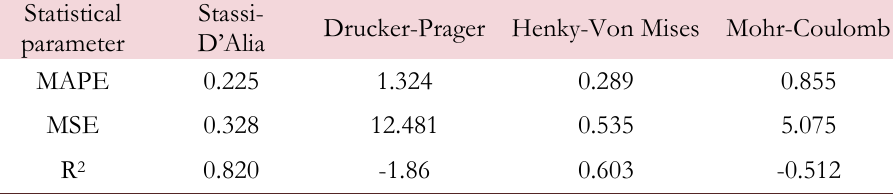
Table 2: Statistical parameters to comparison the theoretical and the experimental results, with a confined lateral stresses, calculated according to Eqn. (13).